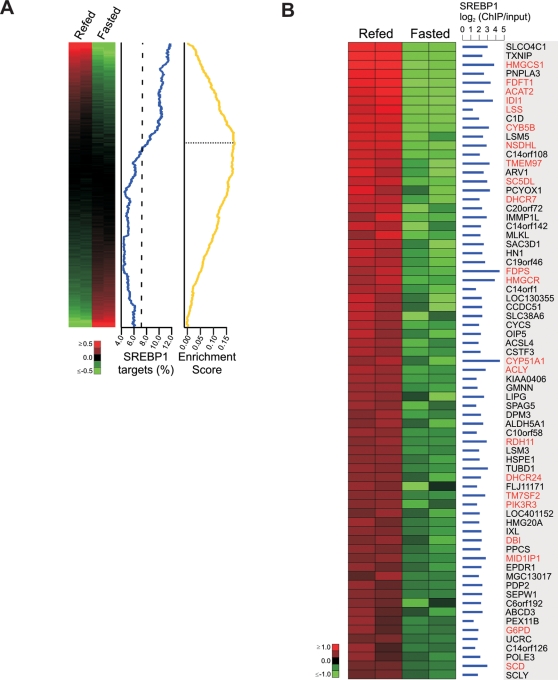
Gene expression changes of SREBP1 targets in fasted and refed HepG2 cells.A) Correlation of ranked gene expression data with SREBP1 occupancy. Left panel, replicate expression measures of 14,857 genes ranked by fold induction in the refed state are displayed as a heatmap. Middle panel, the corresponding percentage of genes occupied by SREBP1 in a 2000 gene sliding window. The dashed line indicates the expected percentage (i.e. the overall percentage of interrogated genes occupied by SREBP1). Right panel, GSEA [27] enrichment score plot. The enrichment score is a running sum statistic that, beginning with the top-ranking gene, increases when an SREBP1 target gene is encountered and decreases otherwise [27]. Enrichment of SREBP1 targets at the top of the ranked list results in a large positive deviation of the enrichment score from zero, indicated by the dotted line. In total, 555 out of 1066 represented SREBP1-occupied genes are located above this line and account for the significant (P<10−3) association of SREBP1 targets with the top of the ranked list. B) Detailed view of 71 SREBP1 target genes exhibiting greater than 1.75-fold higher expression in the refed state. Replicate expression measures are shown as a heatmap with the corresponding SREBP1 enrichment from ChIP-chip and gene symbol displayed on the right. Gene symbols of known SREBP1 target genes are indicated in red.